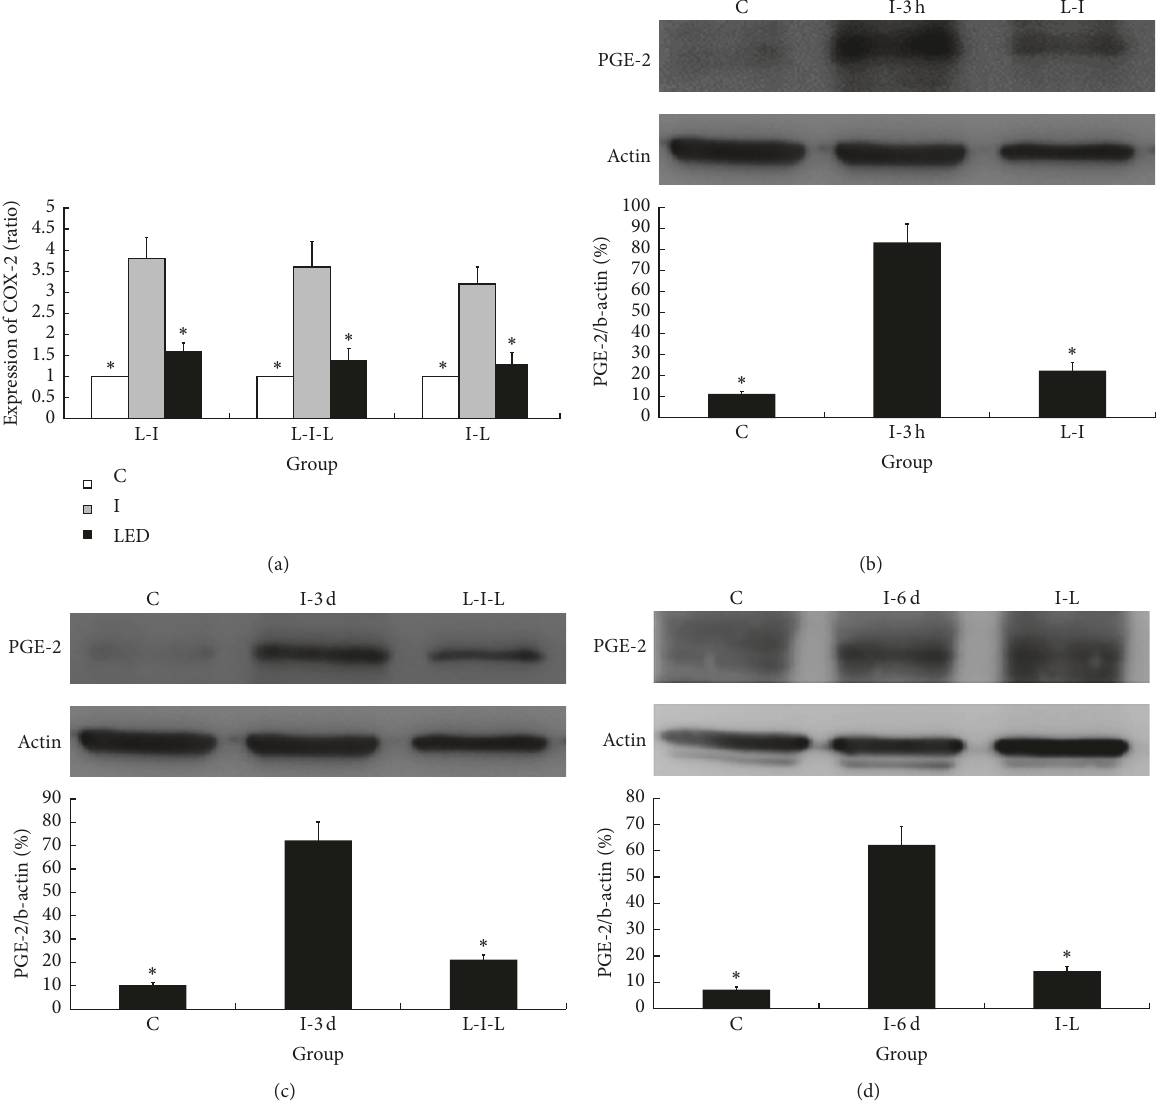
Figure 3: Changes in mRNA levels of cyclooxygenase-2 (COX-2) and representative western blots of prostaglandin E2 (PGE2) expression after LED irradiation. COX-2 mRNA is shown in (a), and representative western blots of PGE2 expression after LED irradiation are shown in (b, c, and d). Compared with the C groups, significant upregulation of COX-2 and PGE2 was noted in the I groups. Significantly decreased expression of COX-2 and PGE2 was noted in the LED irradiation groups compared with the incision only group. C indicates LED irradiation for 6 days on sham skin incision in the paw contralateral to the LED-irradiated paw; I-3h, I-3d, and I-6d indicate incision only groups that underwent behavioral testing 3 hours, 3 days, and 6 days after skin incision; L-I indicates LED irradiation for 6 days before skin incision; I-L indicates LED irradiation for 6 days after skin incision; L-I-L indicates LED irradiation from 3 days before skin incision to 3 days after skin incision. ∗ 𝑝 < 0.05 compared with the I groups. The values represent the means ±